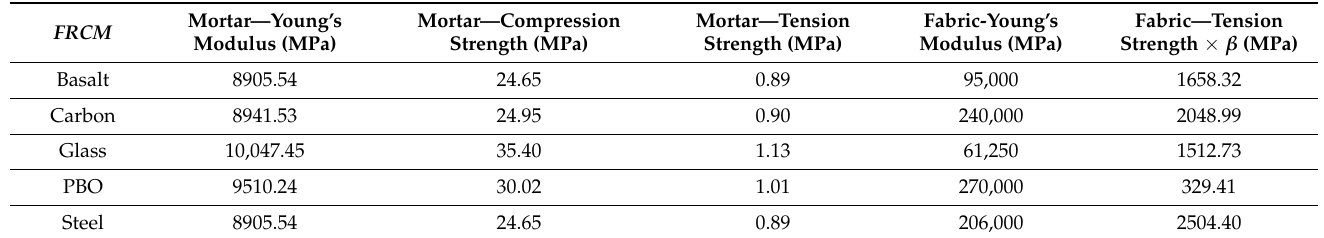
Table 5. Input material properties to the FRCM simulation.